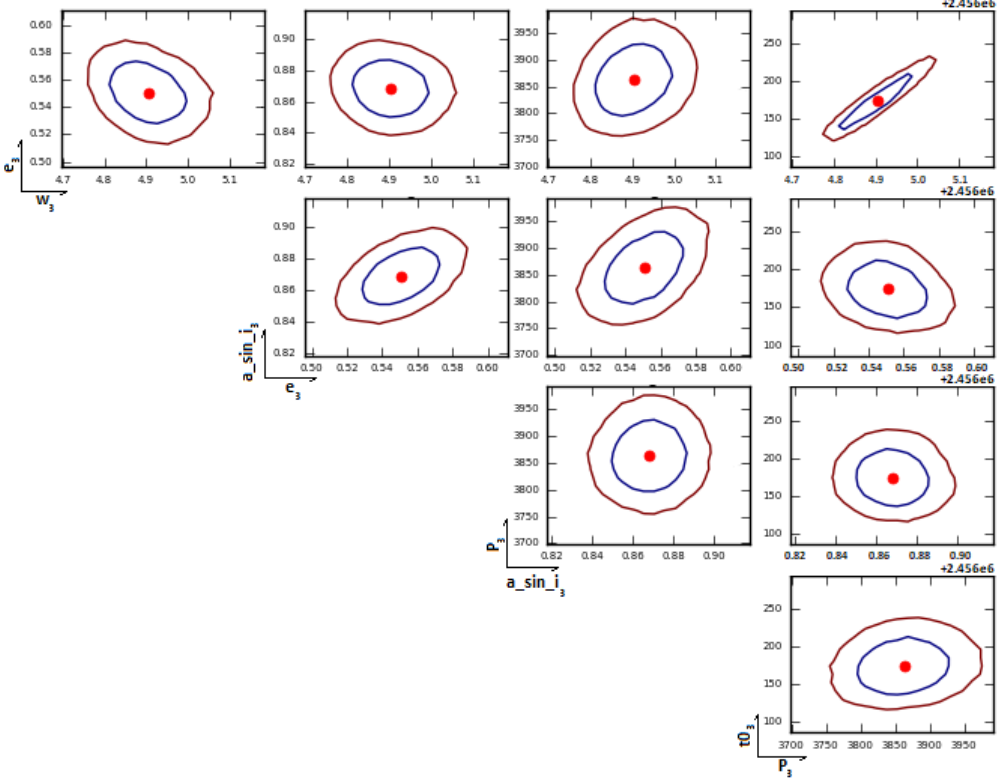
Figure 4. Confidence interval graphs for fitted parameters determined by the MCMC simulation for the LITE model. Red point is solution and regions displayed 1 σ , 2 σ .